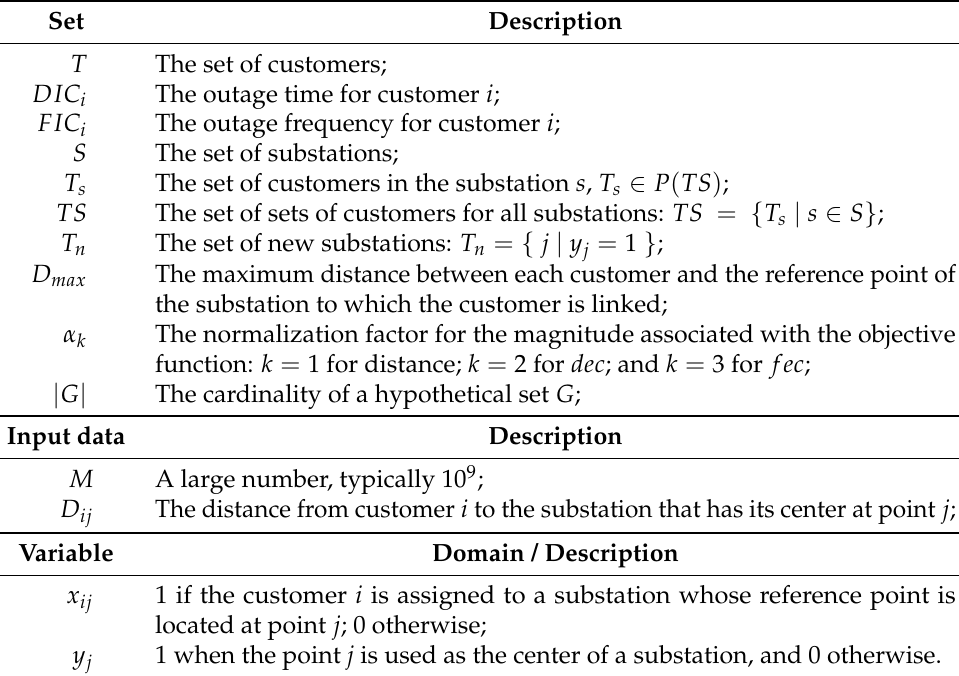
Table 1. Sets, input data, and variables of the p-median